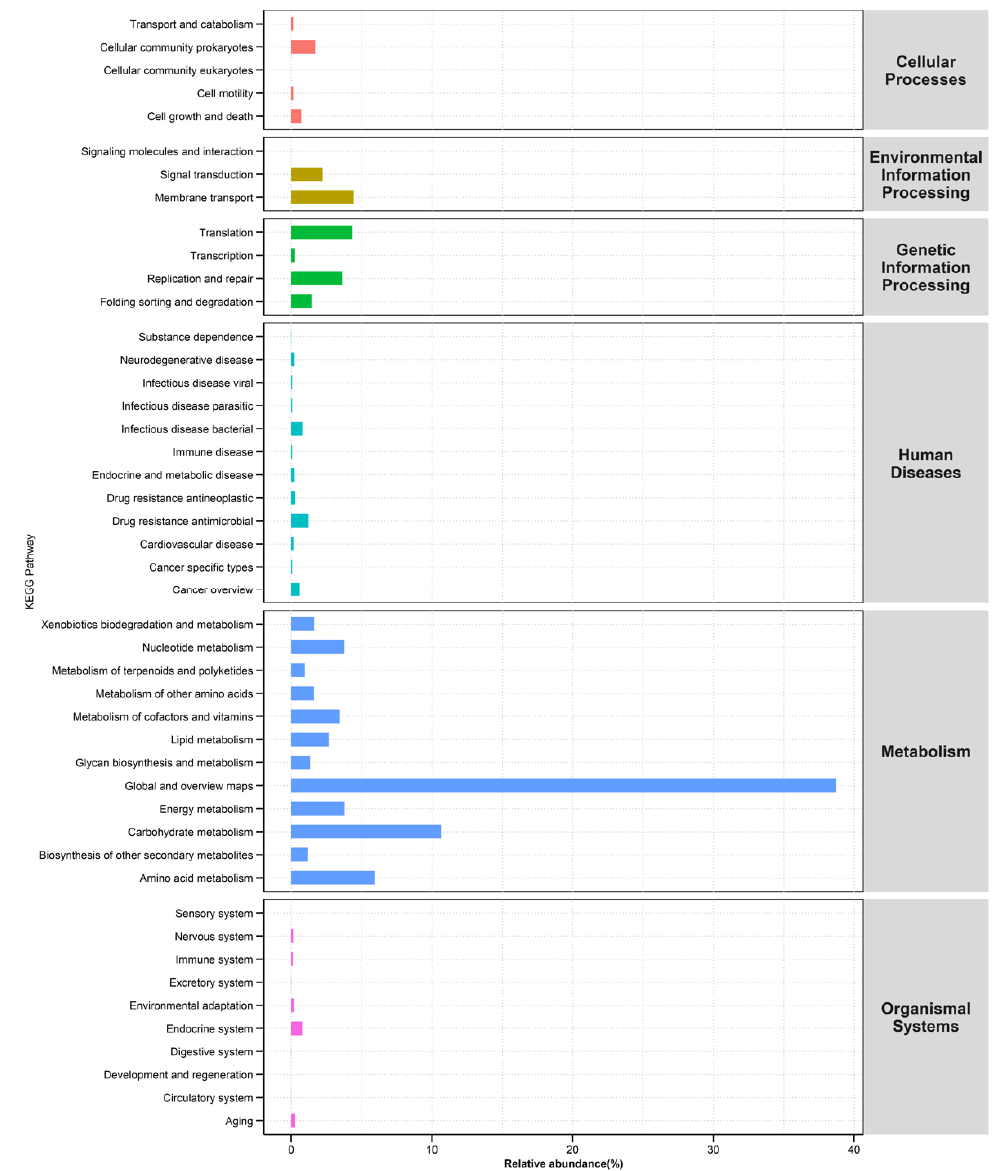
Figure 8. KEGG pathway taxonomic abundance map.